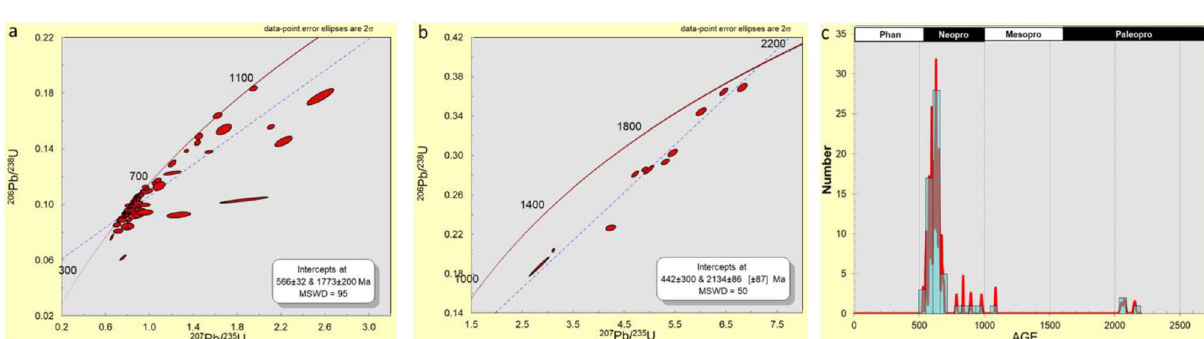
Figure 8. U–Pb concordia diagram of detrital zircon grains ( a ) Ages < 1300 Ma, ( b ) Ages > 1300 Ma, and ( c ) probability density diagram of detrital zircon ages with concordance between 90 and 110% in the studied Awo- Omama kaolins.